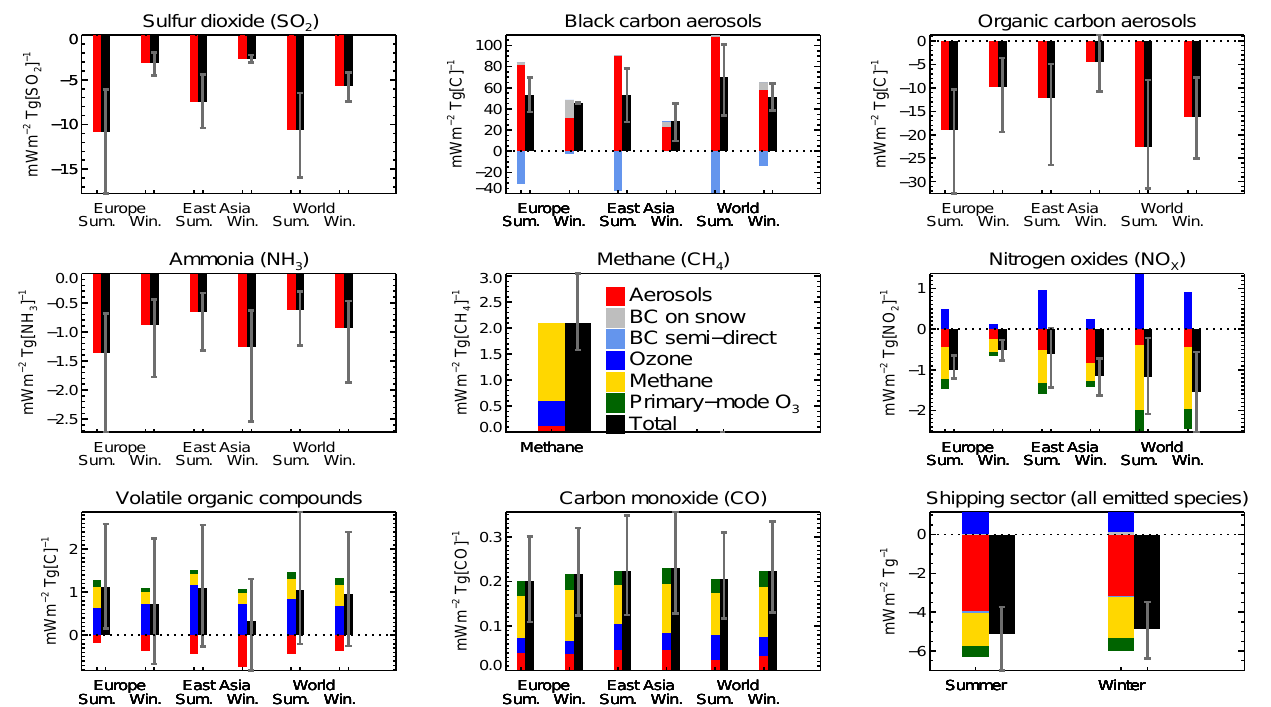
Figure 6. Best estimates of specific radiative forcing for regional and seasonal reductions in near-term climate forcer emissions, in mWm − 2 (Tgyr − 1 ) − 1 . Best estimates are given for six categories of radiative forcing: aerosol–radiation and aerosol–cloud interactions (red), black carbon deposition on snow (grey), black carbon rapid adjustments from semi-direct effects (light blue), short-term changes in ozone (dark blue), methane (yellow), and primary-mode ozone (green). Black bars show the total specific radiative forcing, i.e. the sum of the six components listed above, and whiskers denote the weakest and strongest specific radiative forcing that are obtained by the four participating models or, in the case of ammonia perturbations, estimated from the